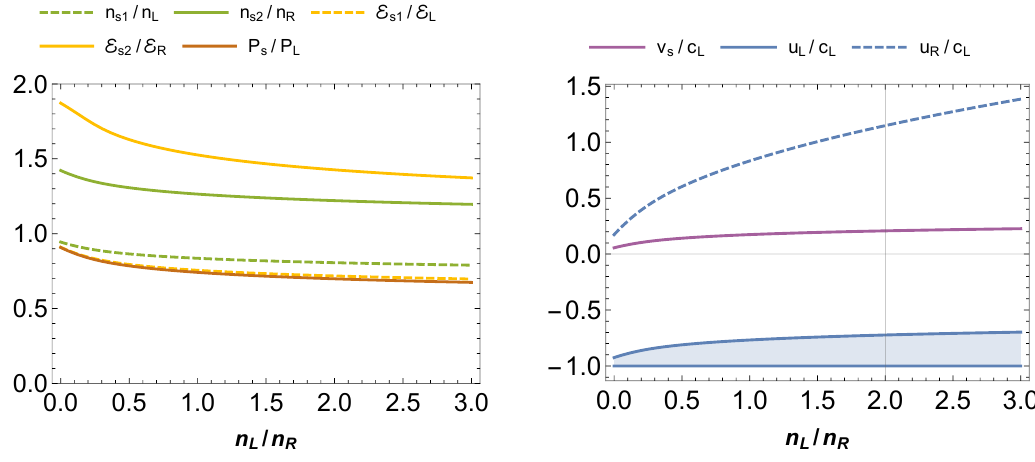
Figure 4. NESS variables for z = 2, d = 3 as a function of n L =n R for (cid:12)xed P L =P R = 2. Left panel: steady state pressure P s , charge densities n s 1 ;s 2 , and energy densities E s 1 ;s 2 . Right panel: (cid:13)ow speed v s , shock speed u R , and wave speed u L across rarefaction